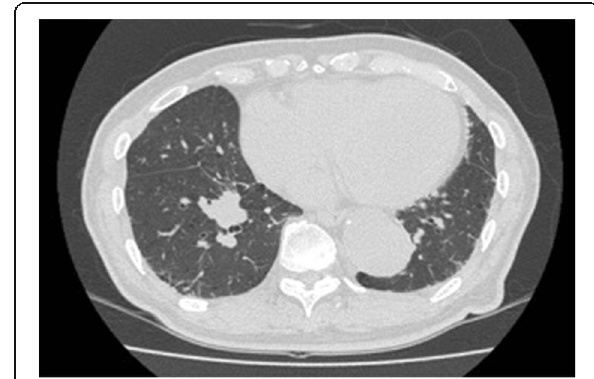
Fig. 1 Axial image of a chest computed tomography (CT) scan